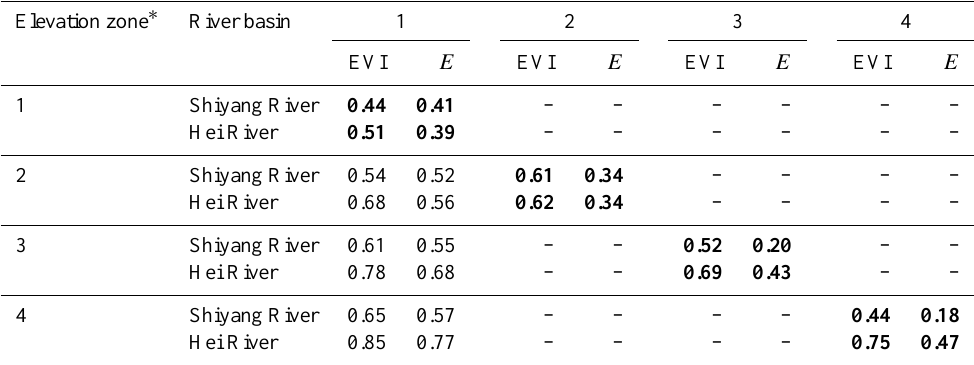
Table 4. Coefficients of determination ( r 2 ) for comparisons between zone-specific precipitation (zones associated with column 1) with same- month, same-zone, or oasis enhanced vegetation index (EVI) and evaporation ( E ; zones associated with row 1) for the Shiyang and Hei river basins, respectively. Cells associated with comparisons that were not addressed in the analysis, are marked with a “–”. Values of r 2 that are in bold are derived for comparisons between zone-specific precipitation with same-month, same-zone EVI and E ; values not in bold, are for comparisons between zone-specific precipitation with same-month oasis EVI and E